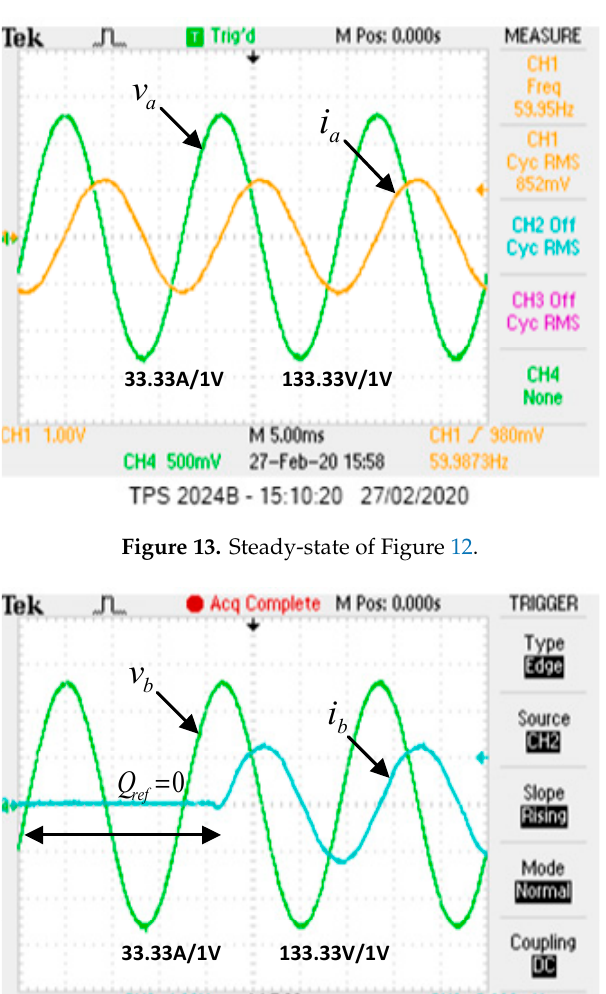
Figure 12. Voltage and current for phase A during Qref = 0 to Qref = 10kVAr and Pref = 0.